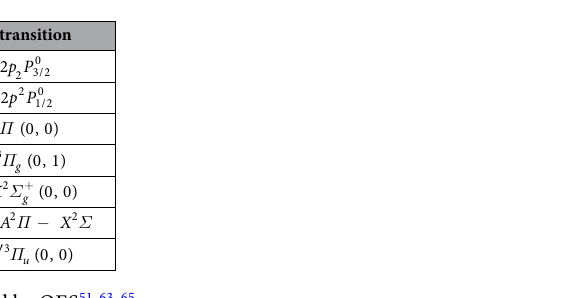
Table 1. Summary of main species detected by OES 51, 63–65